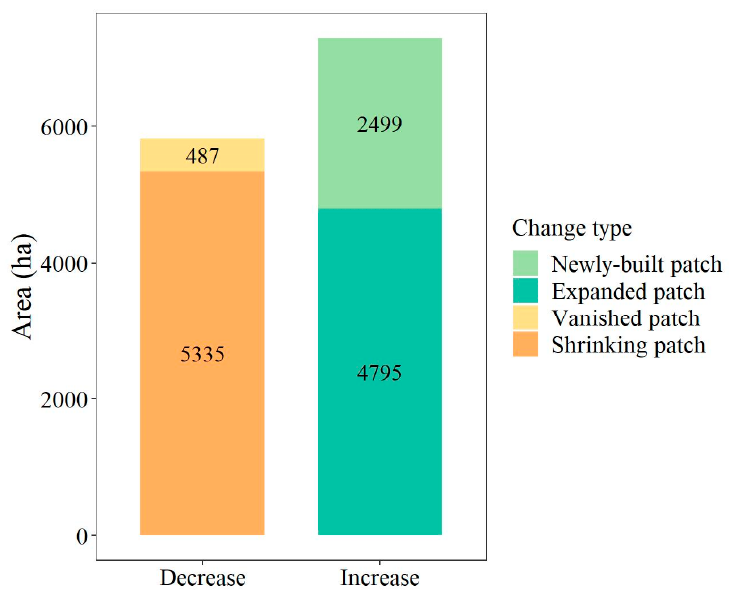
Figure 4. Area of greenspace change from 2005 to 2015. Decrease in greenspace included vanished and shrinking patches. Increase in greenspace included new patches and existing patches that have been expanded.